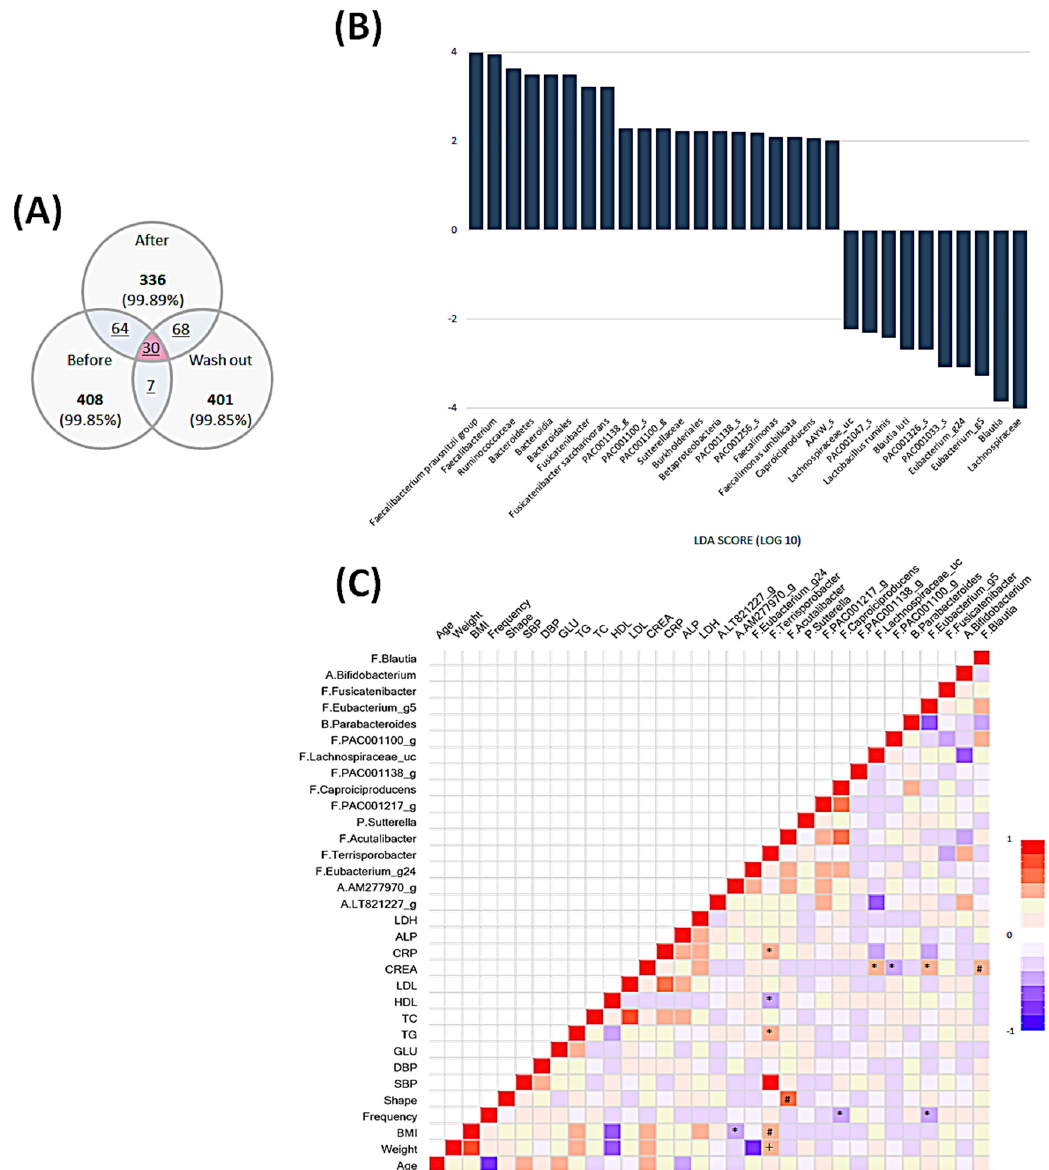
Figure 5. Cross-taxa profile of intestinal microflora and biological parameters in all subjects ( n = 37) compared among the three periods (before, after, and washout). ( A ) Venn diagram showing the distribution of operational taxonomic units (OTUs) for each time point. ( B ) Based on the linear discriminant analysis (LDA) score, 30 significantly altered bacteria represent an increased and decreased group, including 16 genera with significance and tendencies toward significance. ( C ) Heat map of the Spearman rank correlations between biological and gut microbial outcomes. Red indicates a positive correlation and blue indicates a negative correlation. The heat map shows the first letter of the phylum-level bacteria and genus-level bacteria in order. A, Actinobacteria; F, Firmicutes; P, Proteobacteria; B, Bacteroidetes. * p < 0.05, # p < 0.01, and † p < 0.0005 (after false discovery rate correction). Abbreviations: BMI, body mass index; SBP, systolic blood pressure; DBP, diastolic blood pressure; GLU, glucose; TG, triglyceride; TC, total cholesterol; HDL, high-density lipoprotein; LDL, low-density lipoprotein; CREA, creatinine; CRP, C-reactive protein; ALP, alkaline phosphatase; LDH, lactate